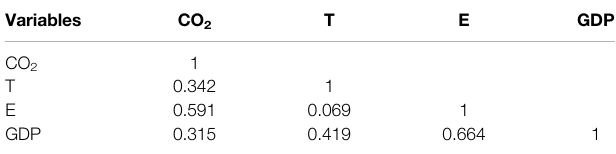
TABLE 1 | Correlation SEAC panel.